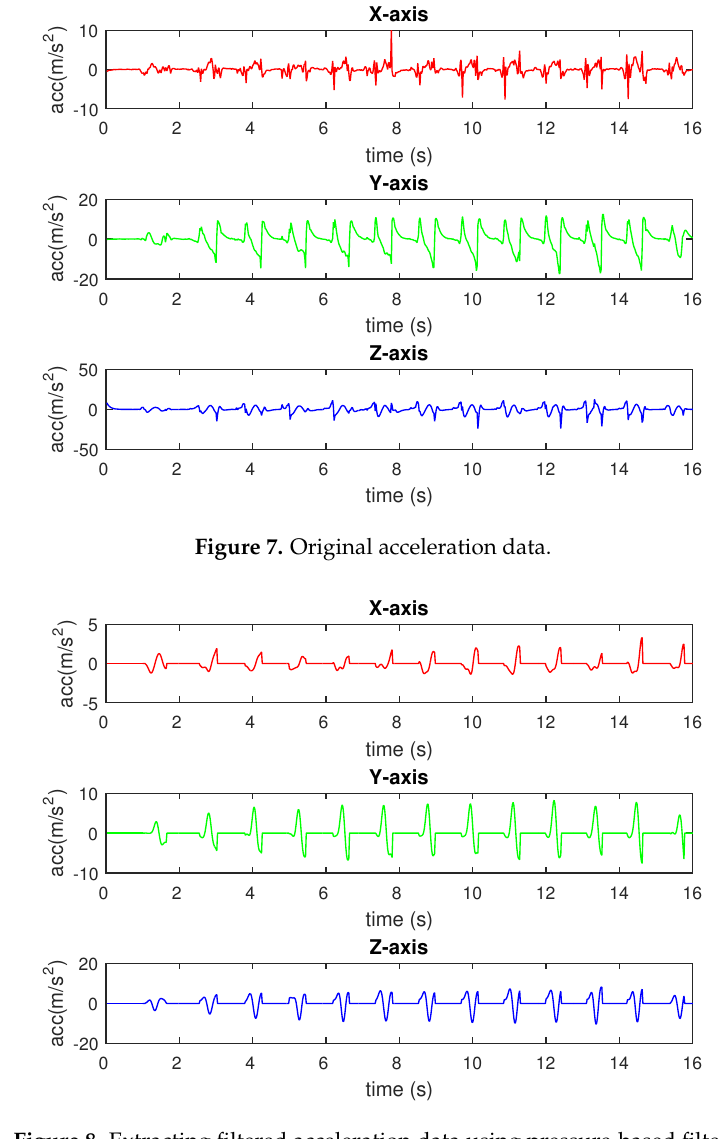
Figure 8. Extracting filtered acceleration data using pressure-based